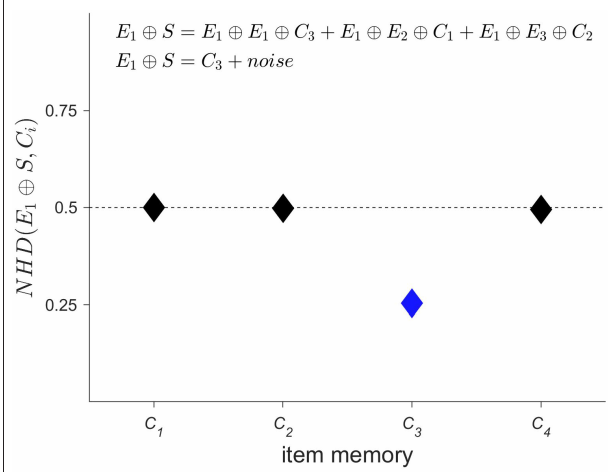
FIGURE 4 | Given a spatial composite representation S , which order relation pattern was recorded by electrode 1? This type of question may be elegantly answered within the framework of hyperdimensional (HD) computing, by binding the HD vector representing electrode 1, i.e., E 1 , with the spatial composite representation S . Using the characteristic that XOR is its self-inverse and that binding produces new vectors that are quasi-orthogonal to their input vectors, one can interpret the result of E 1 ⊕ S as a noisy version of C 3 . This noisy version is then “cleaned up” by measuring its distance to all the HD vectors of the item memory that represent order relation patterns and selecting the most similar one, i.e., C 3 in the present case (displayed in blue). Comparing this result with Figure 3 shows that the correct pattern has been identified. The ability to compute robustly with approximate patterns is a hallmark of computing with HD vectors and lends it naturally as a computational paradigm for novel nano-scale memory-centric hardware with its intrinsic